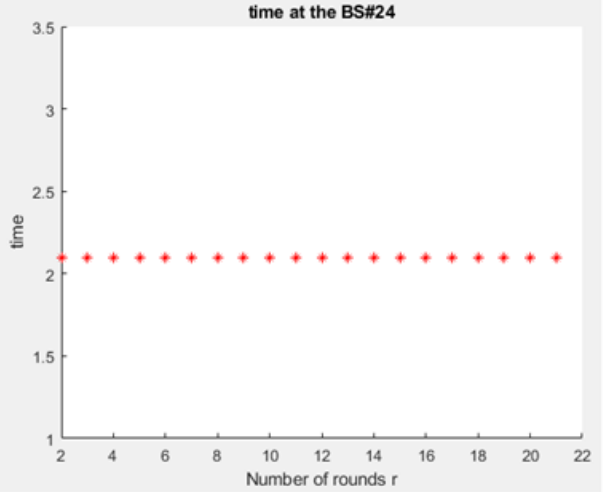
Figure 30. Power profile of a normal node (power consumption for user’s device No.